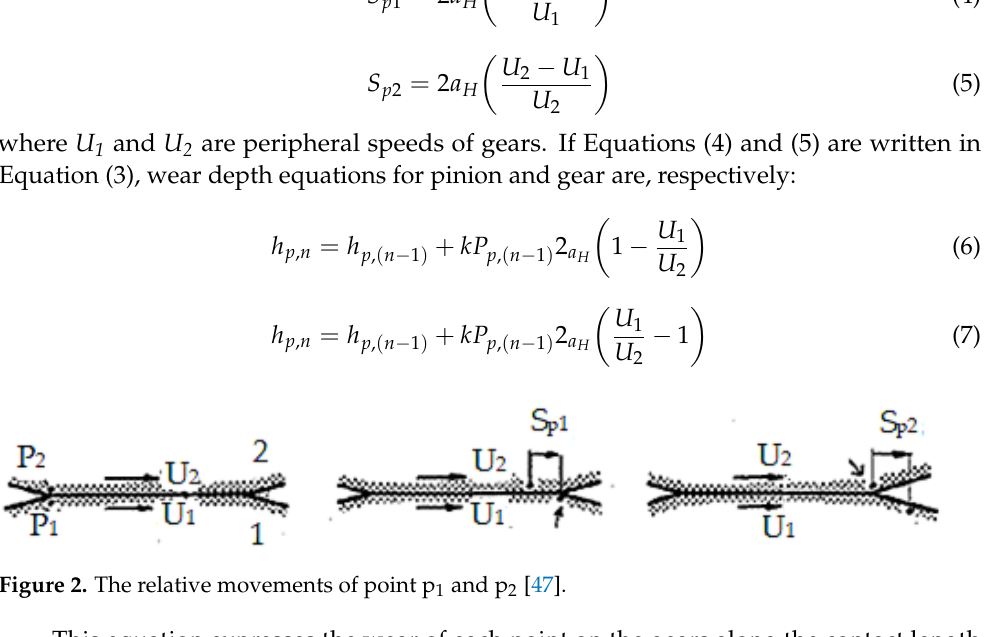
Table 1. Properties of polymeric materials.